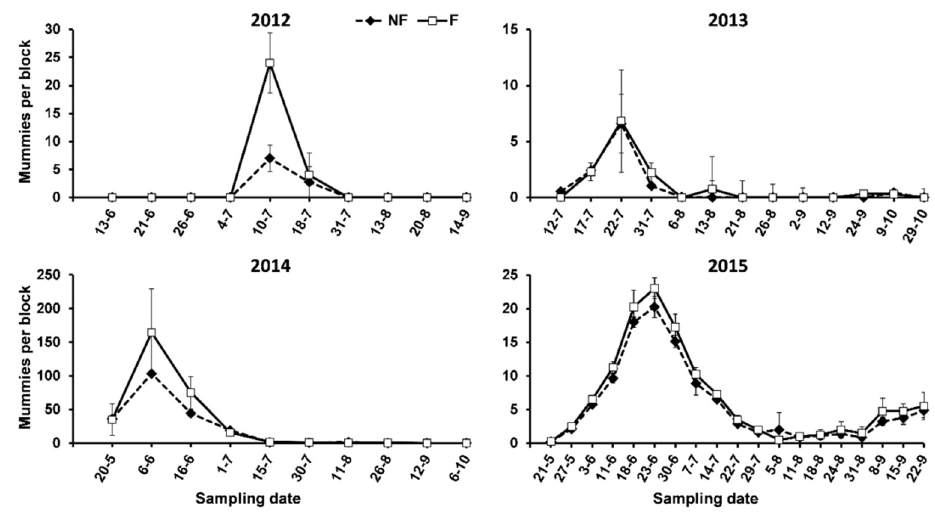
Figure 6. Abundance of aphid mummies on oleanders surrounded (F) and not surrounded (NF) by service plants in the study period.